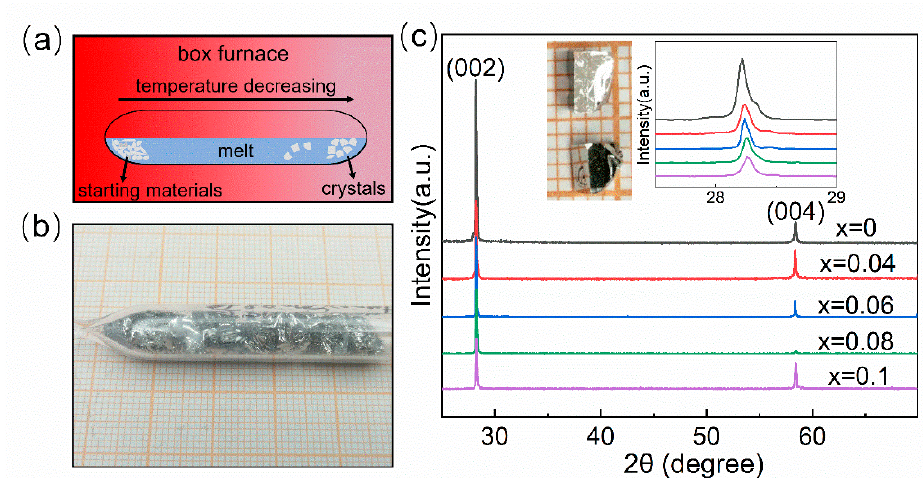
Figure 1. ( a ) Schematic illustration of liquid transport growth method. ( b ) Optical image of quartz ampoules after growth. ( c ) X-ray diffraction (XRD) pattern of In x Sn 1 − x Te single crystals with x = 0, 0.04, 0.06, 0.08 and 0.1, the insets show optical image of as-grown single crystals (left) and enlarged view of (002) peaks (right).